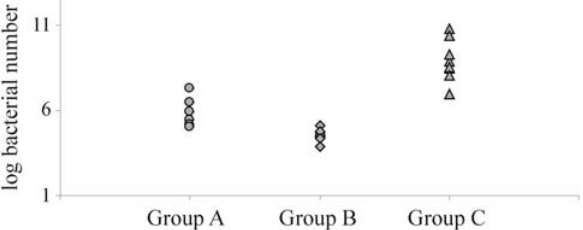
Figure 1 - Number of Helicobacter pylori per 200 ng of total DNA for the different biopsy sample groups. Group A, consisting of 46 biopsies from untreated patients who according to the references methods were consid- ered H. pylori -negative, showed an intermediary level of infection. Group B, made up of 35 biopsies from patients previously treated against H. pylori and considered to be cured by “gold standard” tests, demonstrated a low level of infection. Group C, containing 10 biopsies from patients re- garded as H. pylori -positive by means of all used methods, exhibited a high level of